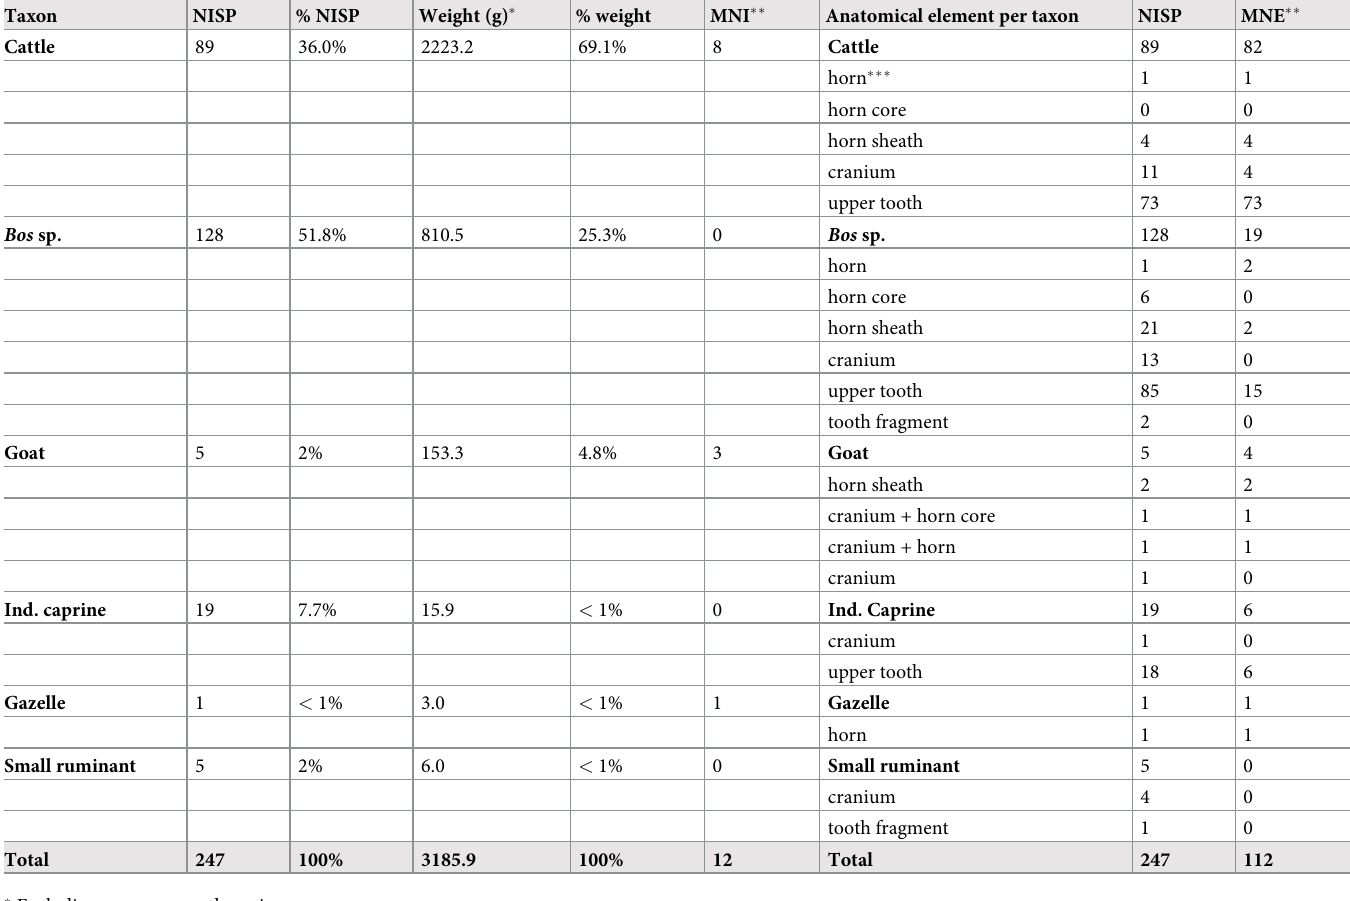
�� estimation considering the whole assemblage ��� horn = horn core +